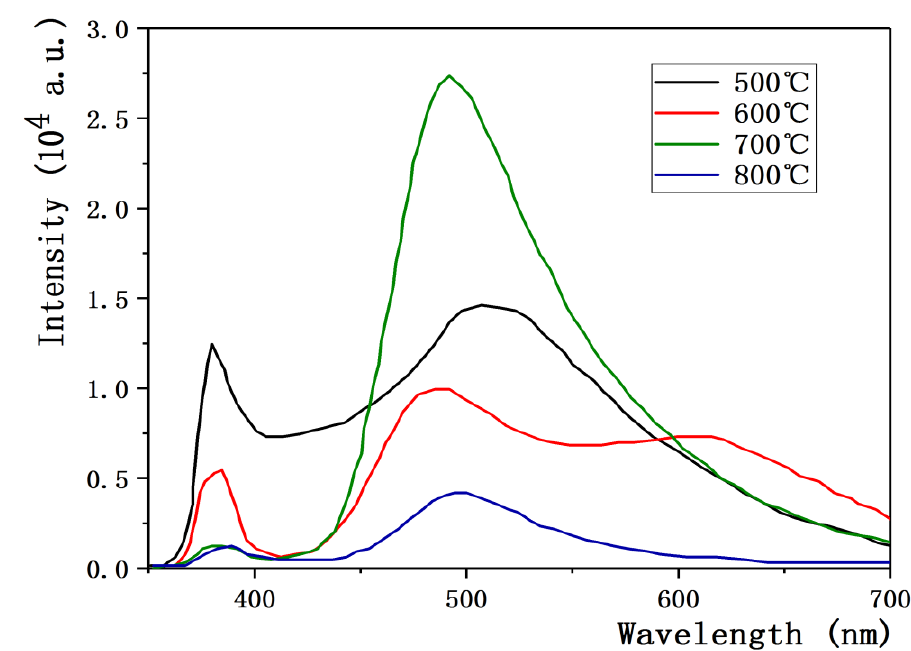
Figure 12. The photoluminescence spectra of ZnO thin films grown at different annealing temperatures [112].